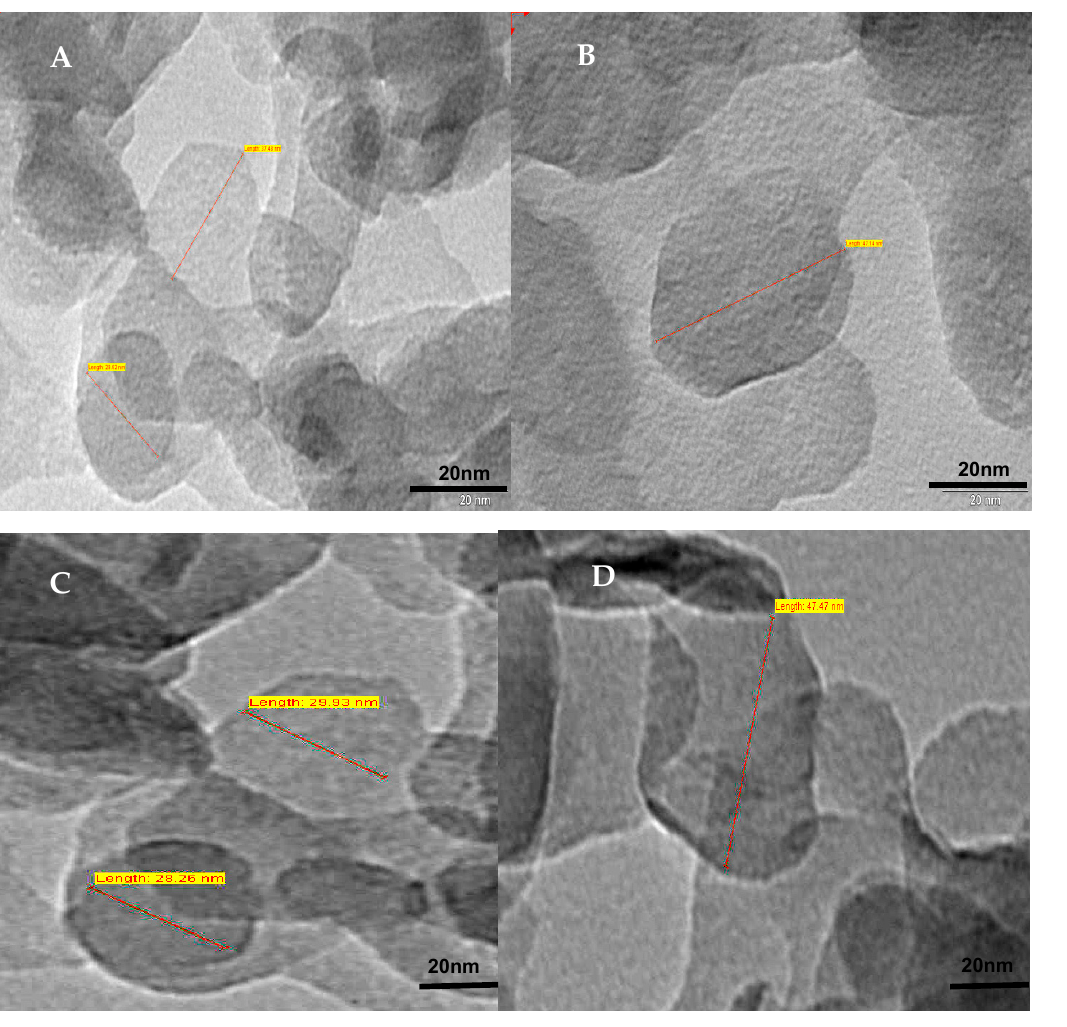
Figure 9. TEM images of Mg/Al (LDH) with hexagonal platelet structures of sizes: ( A ) 25 nm; ( B ) 50 nm; ( C ) 30 nm and ( D ) 45 nm.